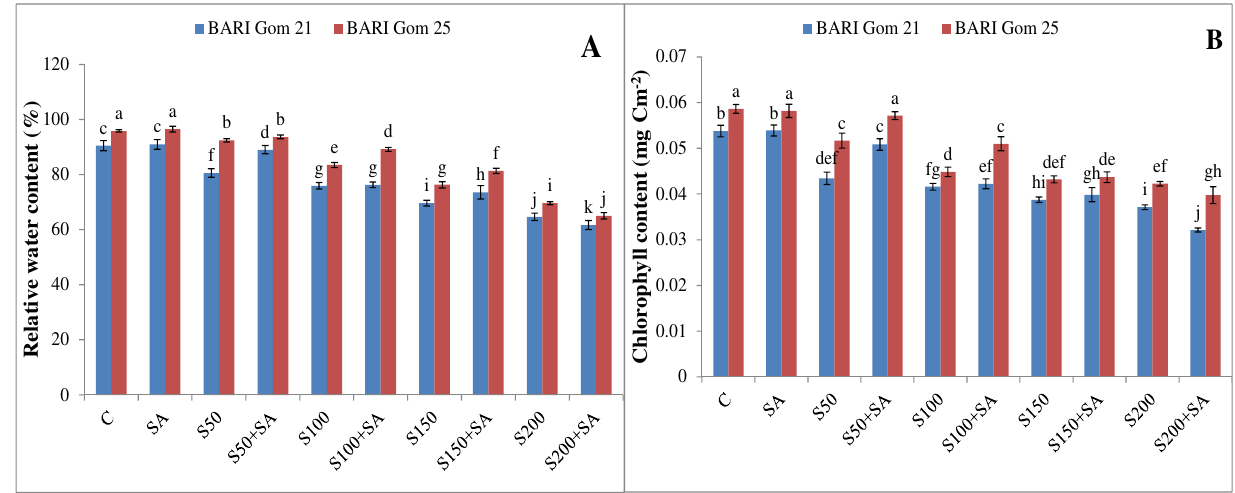
Fig. 1. ( A ) Leaf relative water content and ( B ) chlorophyll content in salt sensitive and salt tolerant wheat plants induced by exogenous salicylic acid under salt stress. S50, S100, S150 and S200 indicate 50 mM, 100 mM, 150 mM and 200 mM NaCl, respectively. SA indicates 1 mM salicylic acid spray, respectively. Mean (±SD) was calculated from three replicates for each treatment. Values in a column with different letters are significantly different at p ≤ 0.05 applying LSD